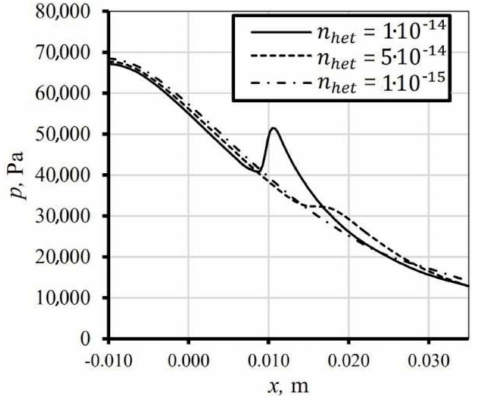
Figure 4. The numerical results for condensing flow with di ff erent number of impurities content and relative humidity equal to